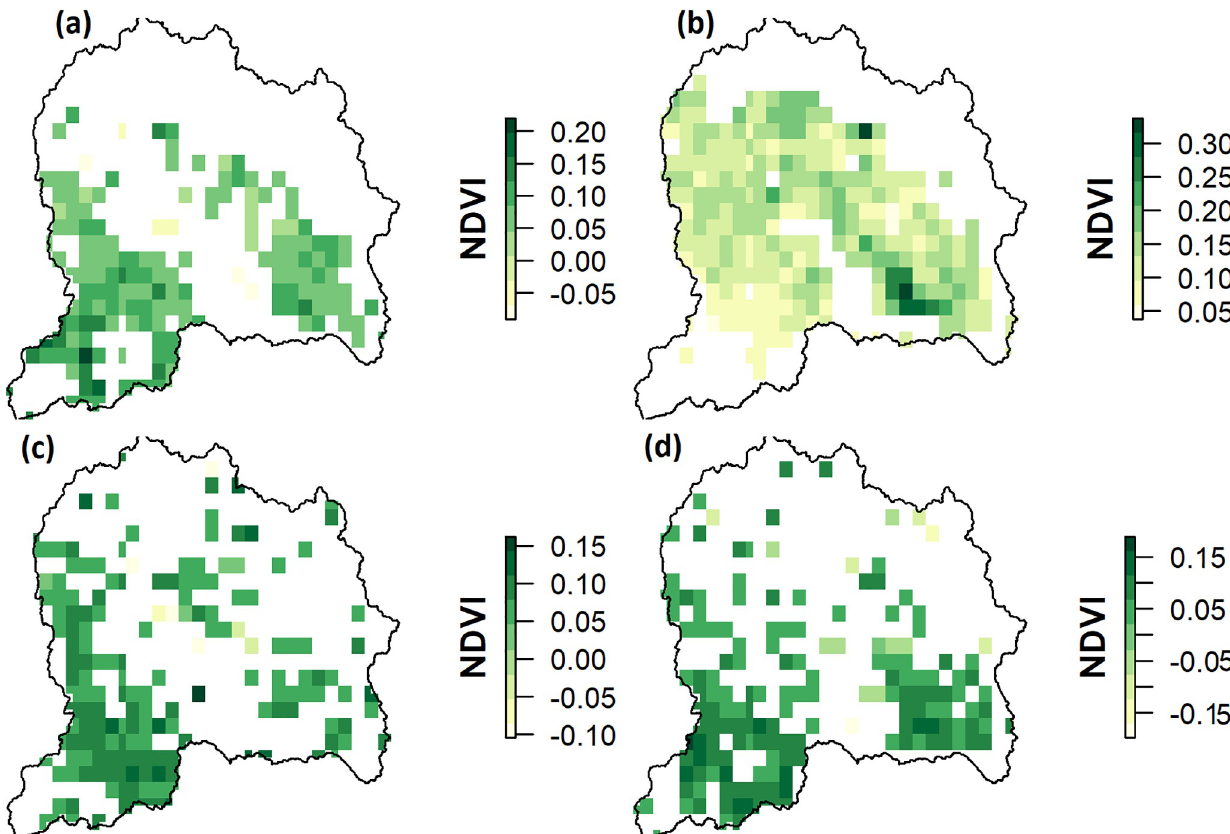
Fig 5. Sen’s slope (p < 0.05) in seasonal NDVI during (a) winter (Q1), (b) spring (Q2), (c) summer (Q3) and (d) autumn (Q4) from 1982 to